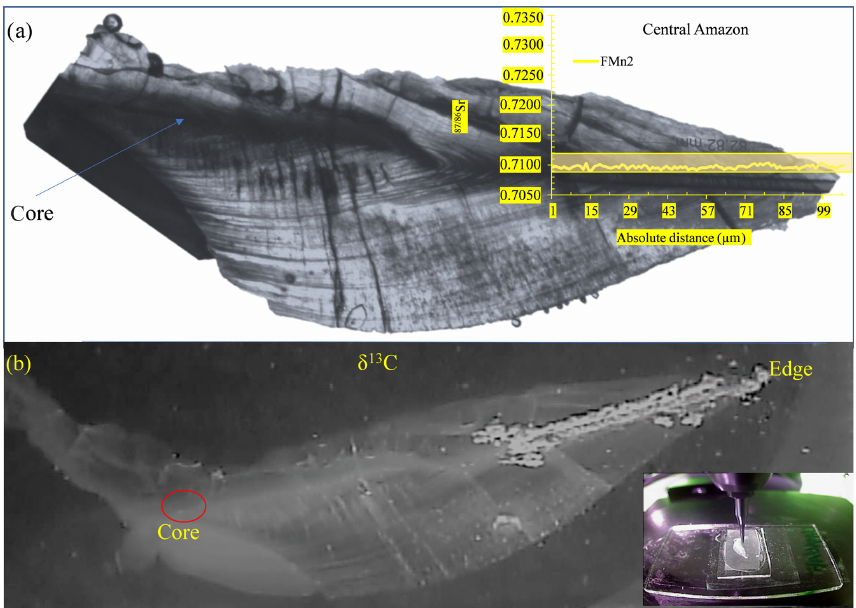
Figure 2. Photographs of an Arapaima’s otolith slice preparation. (a) With the corresponding 87 Sr / 86 Sr isotopic profile over the raster, which corresponds to the final part of a core to edge transect representing the last period of life of the individual before its capture, analyzed by laser ablation. The yellow rectangle illustrates the range of 87 Sr / 86 Sr values of the Solimões waters in the Central Amazon and Lower Amazon. (b) Illustration of the microdrilling sampling performed in the same transect in order to analyze δ 13 C signatures.